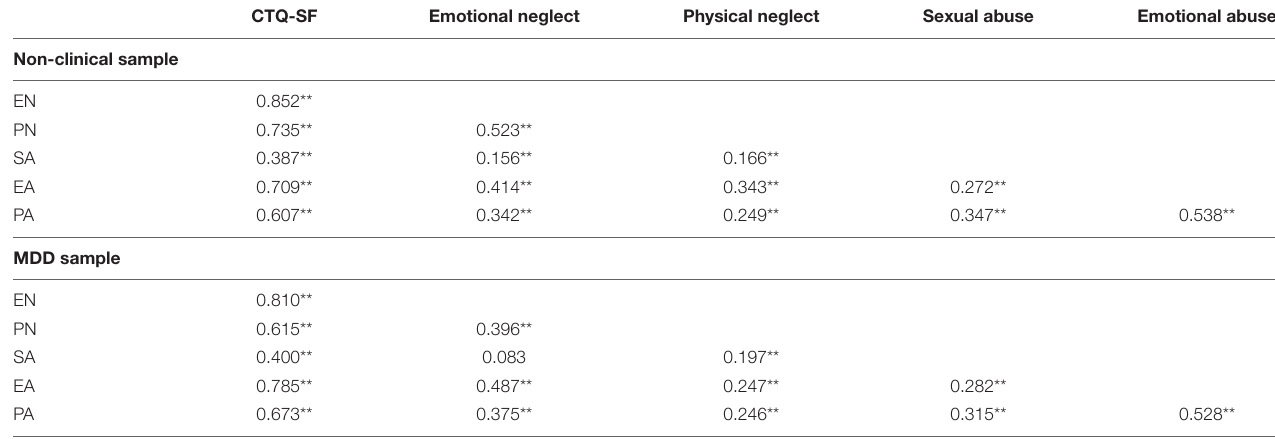
TABLE 6 | Correlations among total and subscale scores of CTQ-SF.